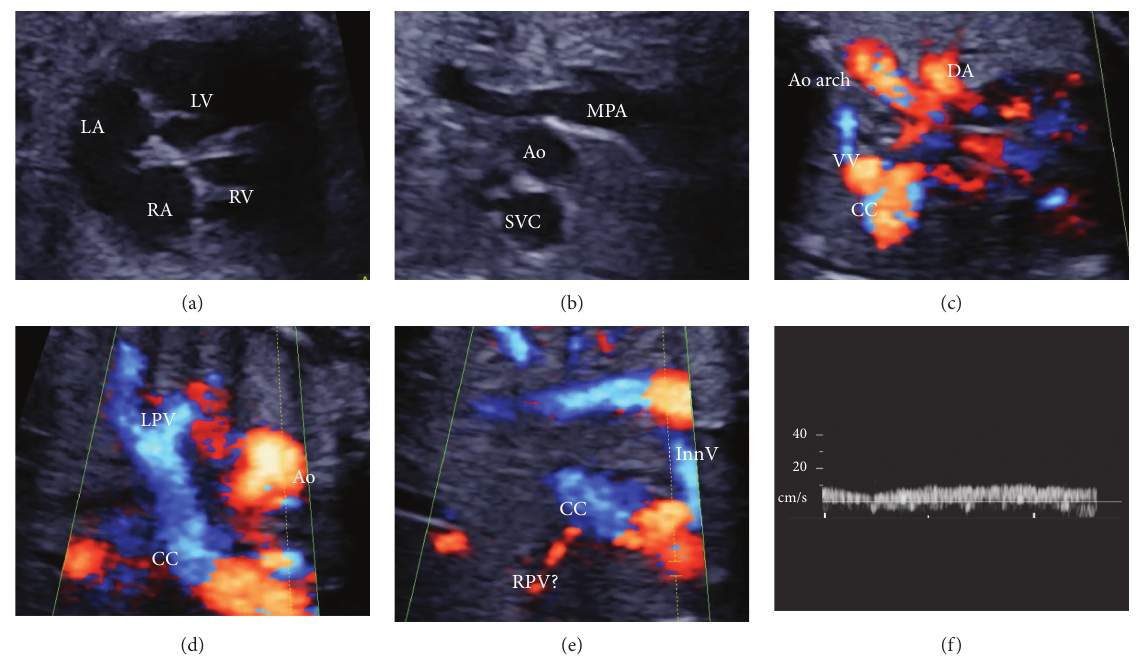
Figure 1: Foetal echocardiography. (a) An atrial septal defect is detected. (b) The superior vena cava is enlarged. (c) Vertical vein (VV) flow from the common chamber (CC) shows a continuous pattern. (d) Left pulmonary vein (LPV) flows into the enlarged CC. (e) The right PV (RPV) seems to flow to the CC. (f) The RPV shows a continuous flow pattern. The A-dip of the flow is seen to disappear. Ao, ascending aorta; Ao arch, aortic arch; DA, ductus arteriosus; InnV, innominate vein; LA, left atrium; LV, left ventricle; MPA, main pulmonary artery; RA, right atrium; RV, right ventricle.